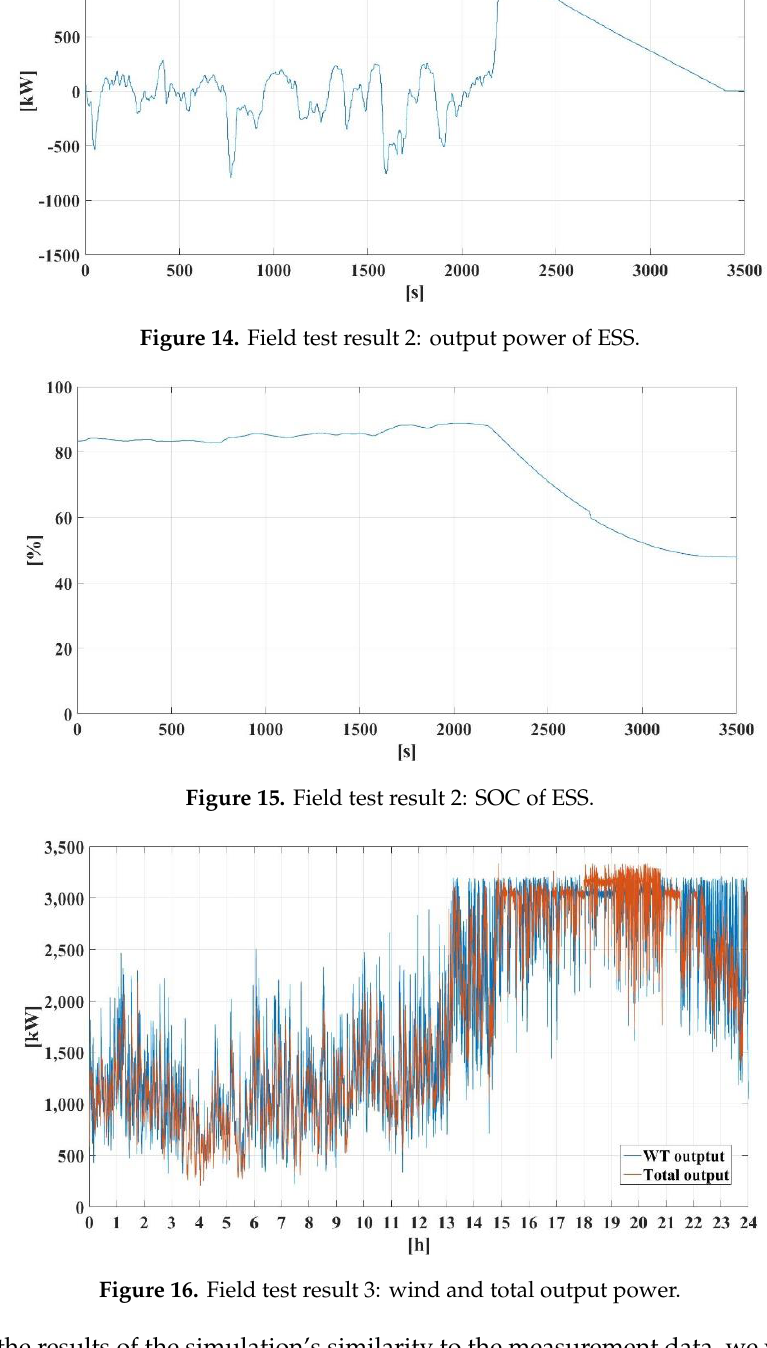
Figure 16. Field test result 3: wind and total output power.